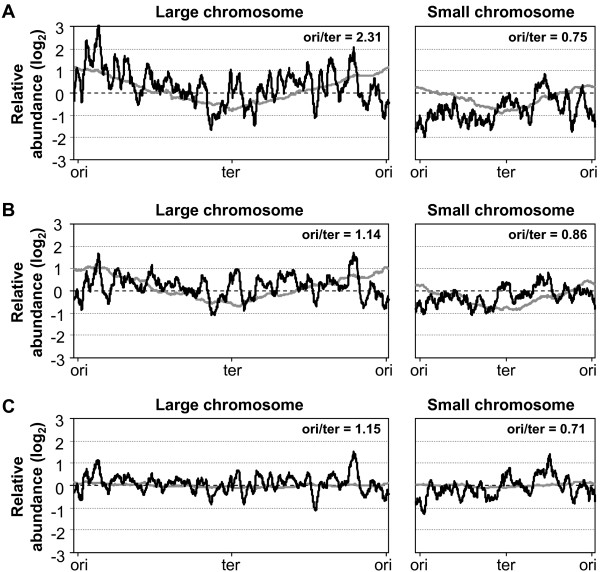
Genome-wide expression in exponentially growing V. parahaemolyticus determined by cDNA/gDNA microarrays. Gene expression was determined by comparing cDNA generated from cells in exponential phase (OD600 ~ 0.5) grown in LB with 3% NaCl at 37°C (A) or 20°C (B) or in M9 with 3% NaCl supplemented with 0.4% glucose (C) against gDNA from non-replicating cells. Results are presented as black trend-lines that show sliding averages for 50 data points. Trend-lines from the previous gDNA quantifications (in grey) are included for comparison. Numbers display ori/ter ratios determined by linear regression analyses on expression data plotted against distances from the origin of replication. Scales on the x-axes display approximate chromosomal lengths.